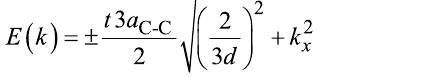
rameter [5,25-29]. The best gas sensor has a high sensitivity and